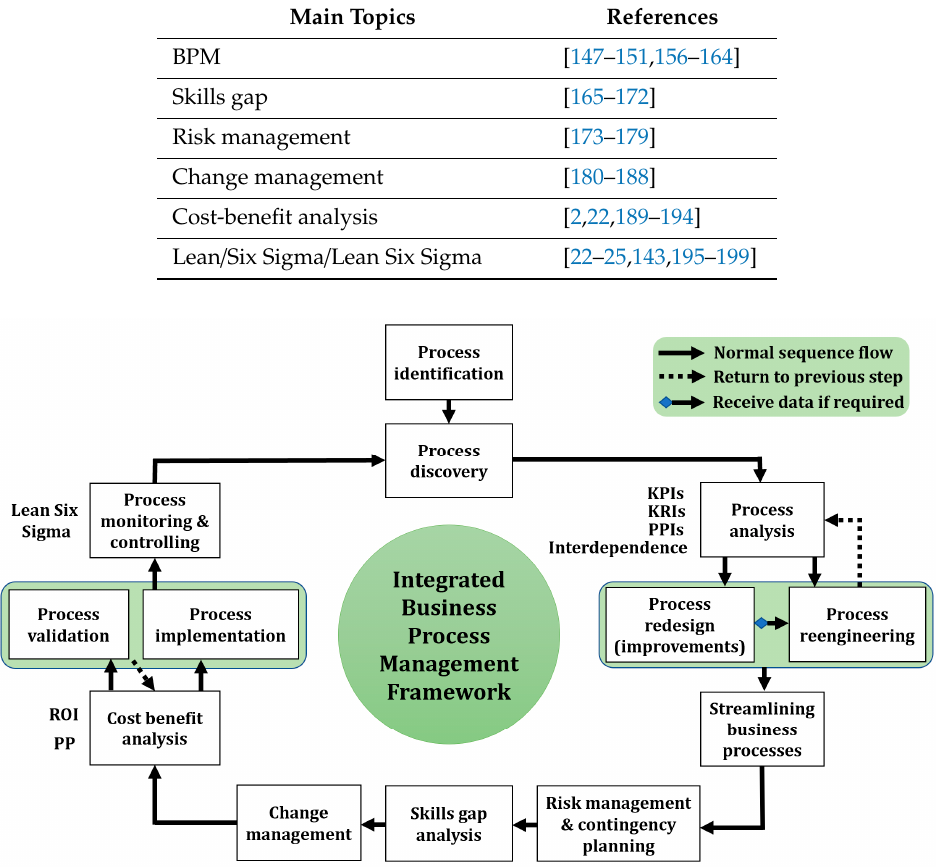
Figure 5. Integrated business process management framework. Table 1. Literature used to support the integrated business process management framework.